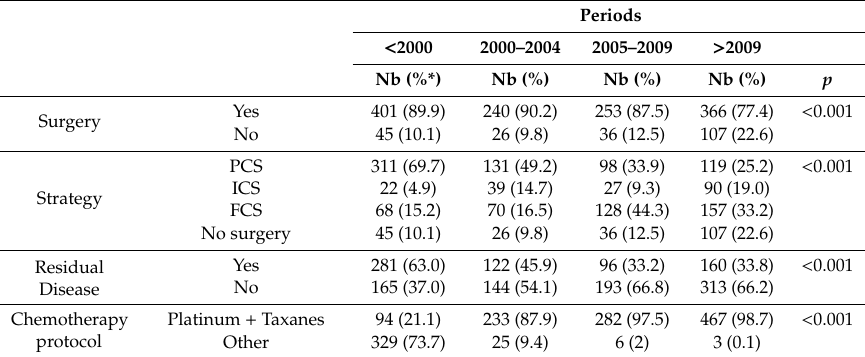
Table 3. Comparison of support based on the periods.